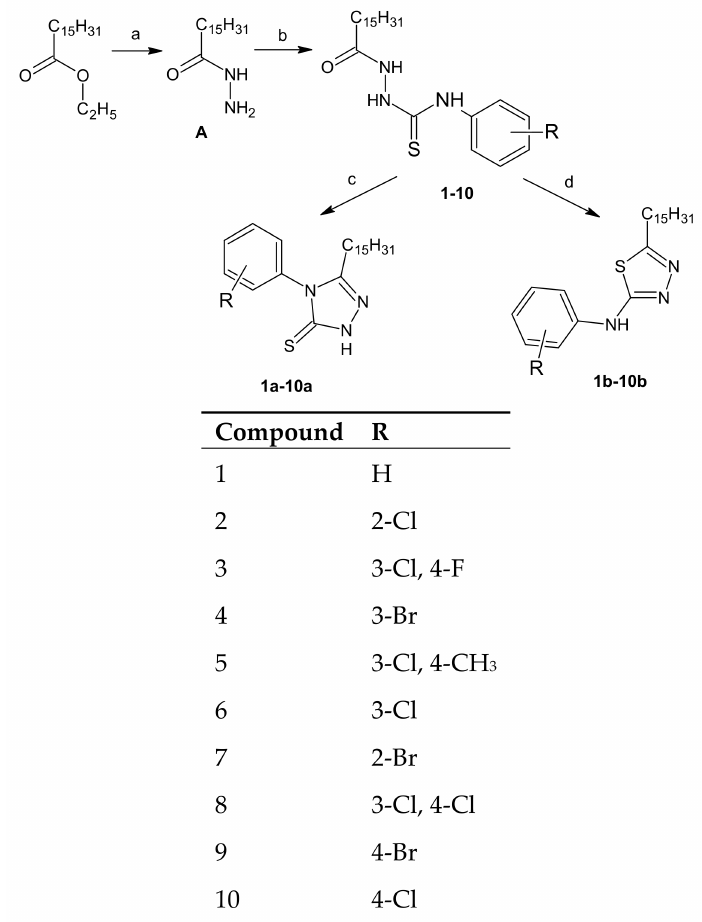
Scheme 1. Synthesis route for derivatives of palmitic acid thiosemicarbazides. Reagents and